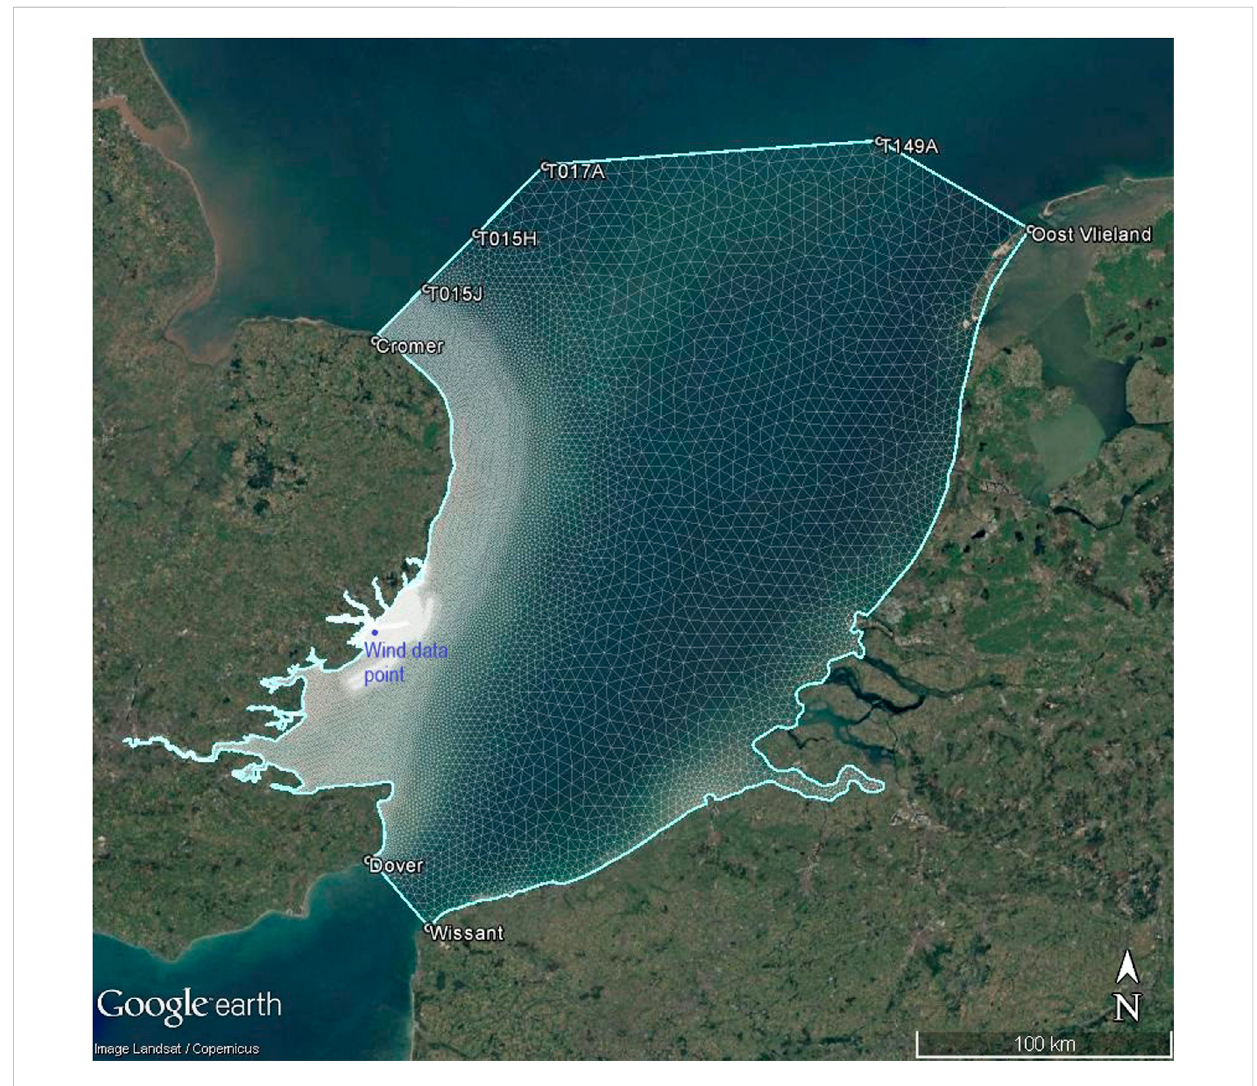
FIGURE 6 Model domain and mesh, showing locations of Admiralty tide gauge stations